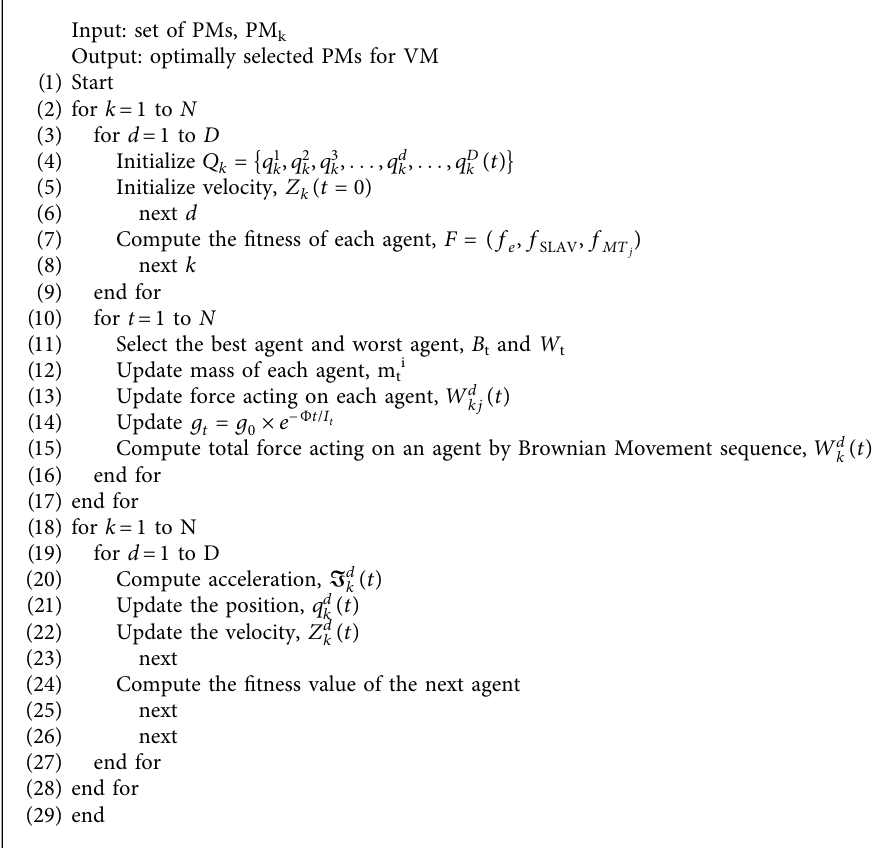
A LGORITHM 2: BMGSA for optimal VM allocation.